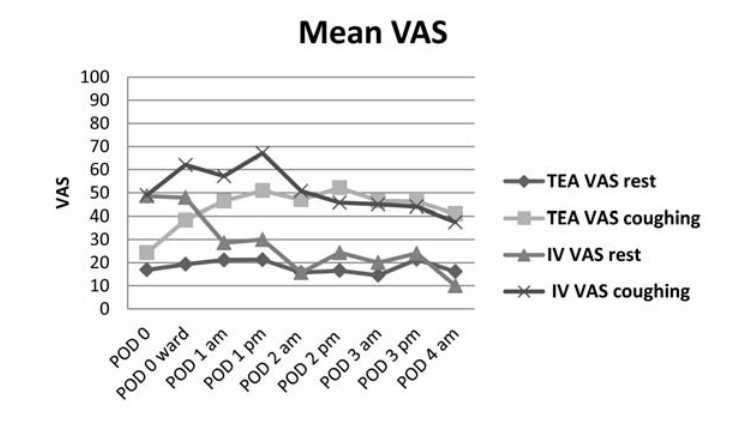
Figure 1. Mean visual analogue scale (VAS) score (0-100); thoracic epidural analgesia (TEA) and IV analgesic group, at rest and coughing, during post-operative day (POD) 0-4.